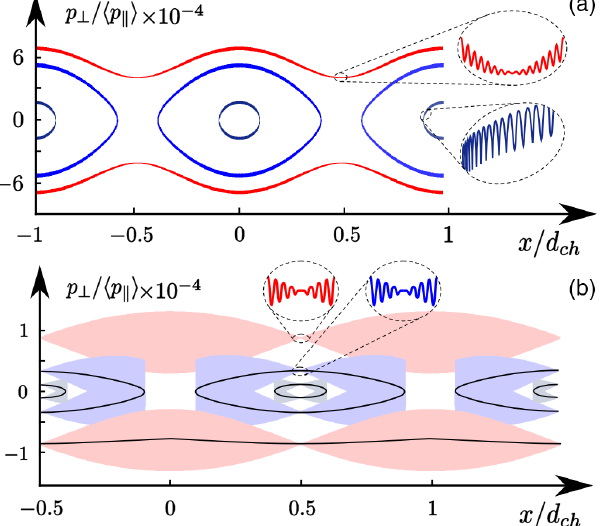
FIG. 3. Numerically calculated transverse phase-space trajec- tories for electron with β ∥ ¼ β min (a) and β ∥ ¼ 0 . 99986 (b) mov- ing in a channel formed by two p-polarized lasers of λ ¼ 800 nm wavelength and 5 TW = cm 2 intensity for each one. The electron transverse momentum is normalized by the averaged longitudinal momentum, while the transverse coordinates by the channel ≡ λ = ð 2 sin η Þ . Channeled (under-barrier) trajectories width d 0 ch are shown in blue, while quasichanneled (over-barrier) in red. The rapid oscillations could not be properly visualized and are outlined near the plots. The averaged phase-space trajectories are also demonstrated in solid black lines. To build these trajectories the 4th order Runge-Kutta method was used for the electrons motion equations integration.